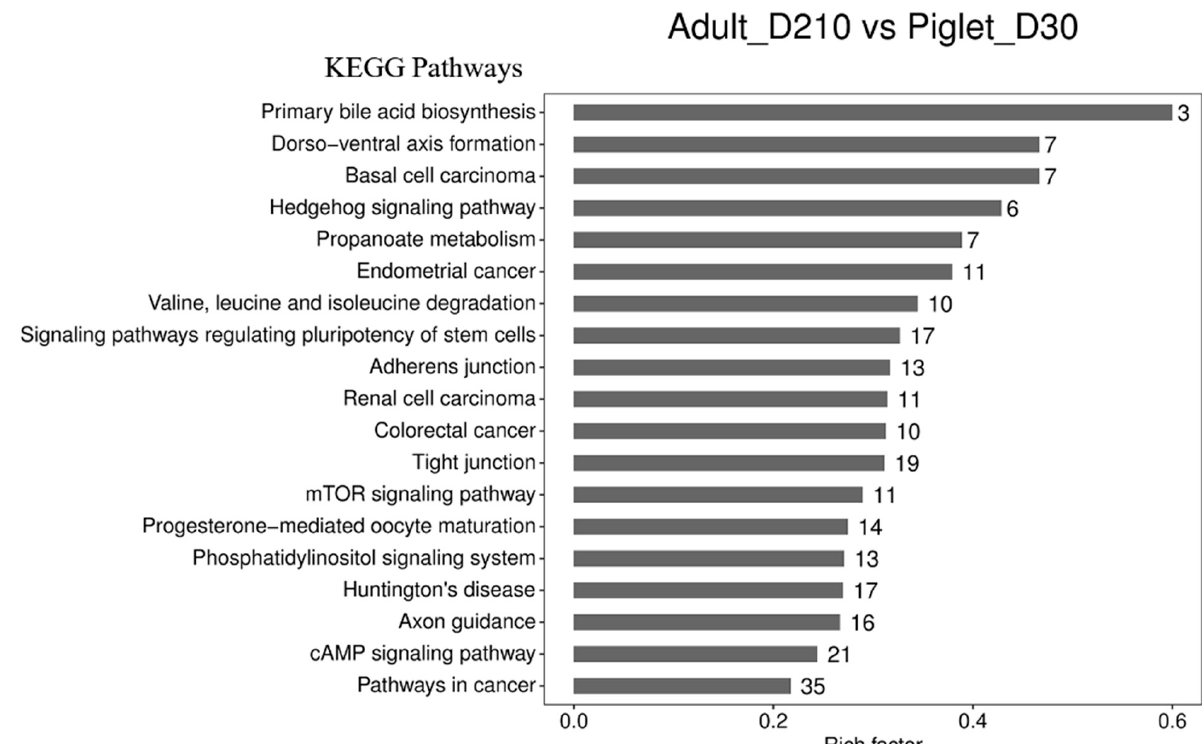
Figure 6. Kyoto Encyclopedia of Genes and Genomes (KEGG) analysis of hosting genes of differentially expressed circRNAs. Analysis of KEGG signals pathways of the source genes of circRNAs with the largest differential expression in young (Piglet-D30) and sexual mature (Adult-D210) boar testes. All 19 KEGG signal pathways with significant differences are listed.